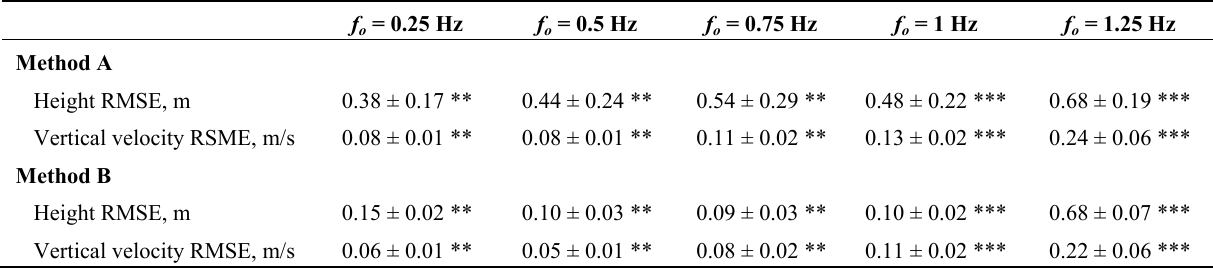
Table 4. RMSE statistics expressed as mean value ± standard deviation (SD) across N = 10 trials.